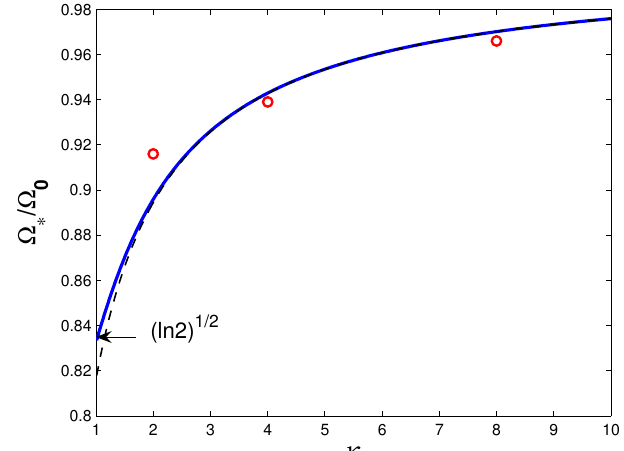
Figure 3. Normalized natural frequency as function of distance to boundary ( h / R 0 ) . Solid circles show the measured values [3]. The dashed line corresponds to case where only monopole component of interaction between bubble and its mirror image is taken into